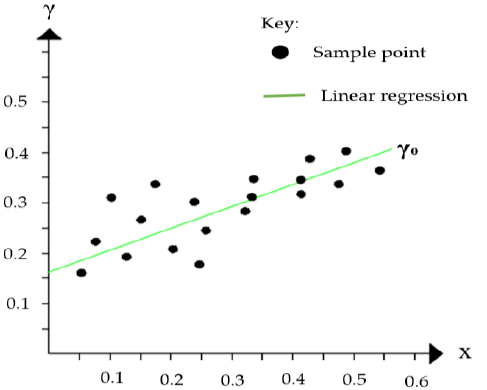
Figure 4. Point distribution around the fitted plane on the x-y plane, and the estimated root mean square error.